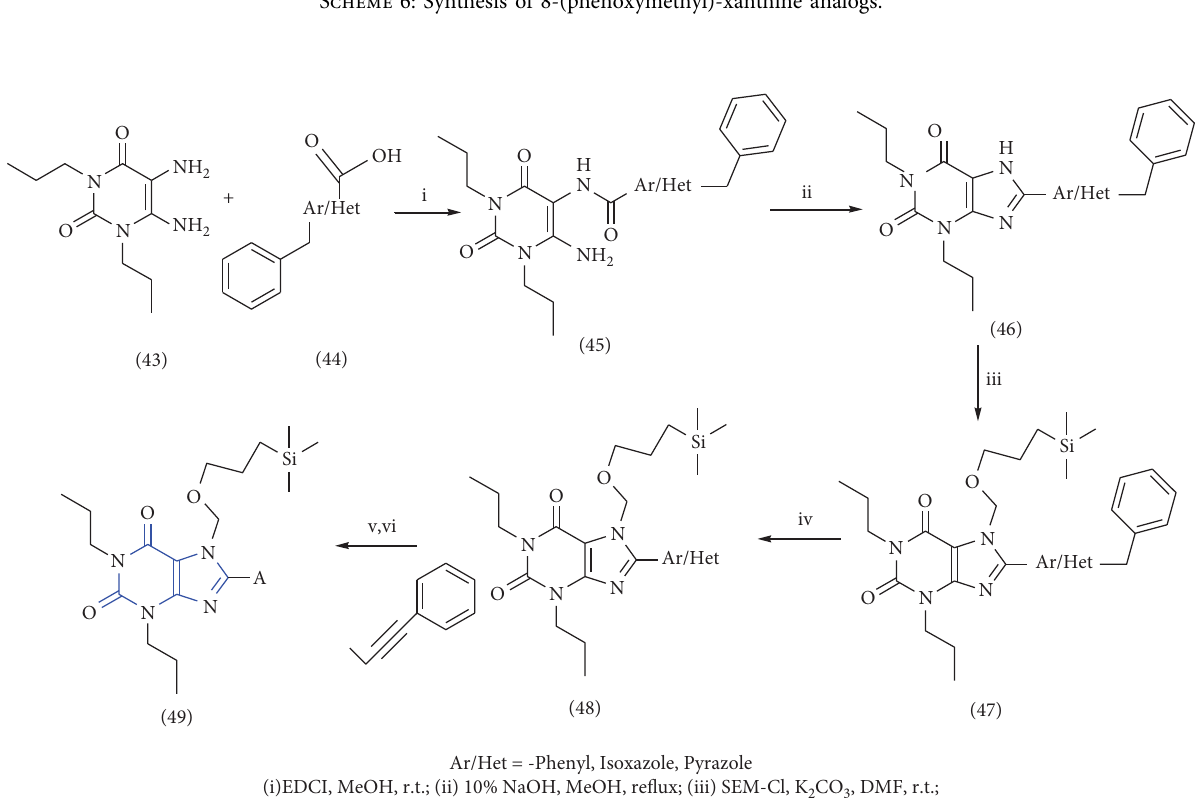
Scheme 6: Synthesis of 8-(phenoxymethyl)-xanthine analogs.